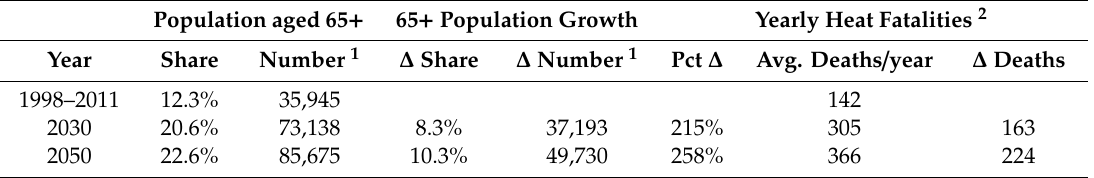
Table 8. Increase in heat fatalities given the projected growth of the elderly population in 2030 and